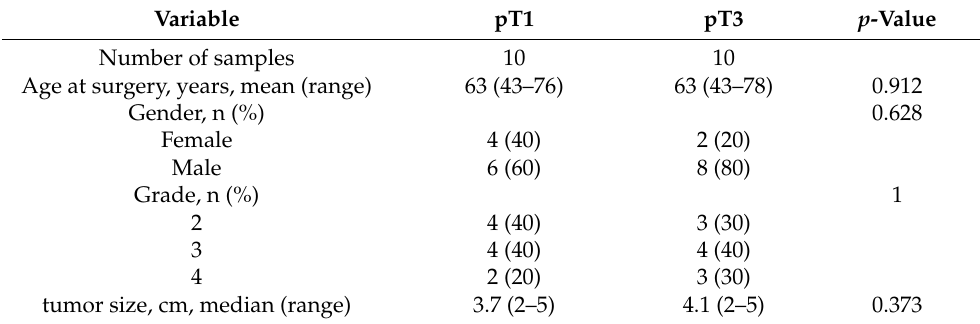
Table 1. Clinical and pathological characteristics for all of the samples in this study. Variable pT1 pT3 p -Value Number of samples